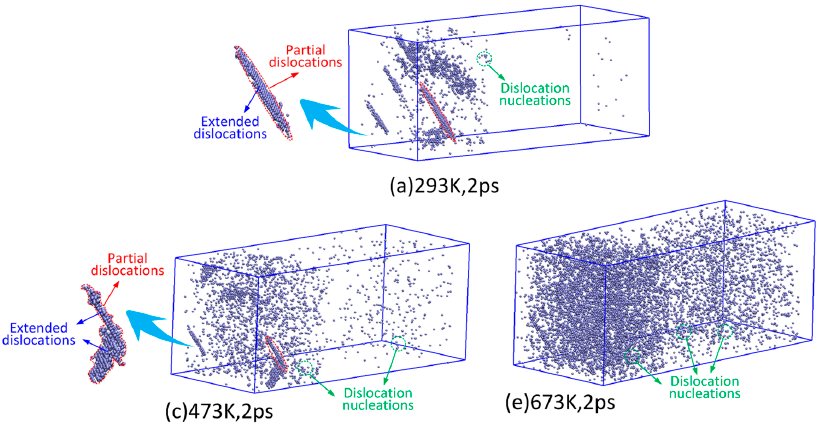
Figure 7. Evolution of dislocation atoms induced by the laser shock wave at 2 ps under different temperatures; ( a ) 293 K; ( b ) 473 K; and ( c ) 673 K.